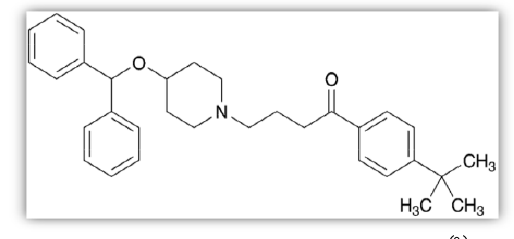
Figure 1. Chemical structure of Ebastine (9)